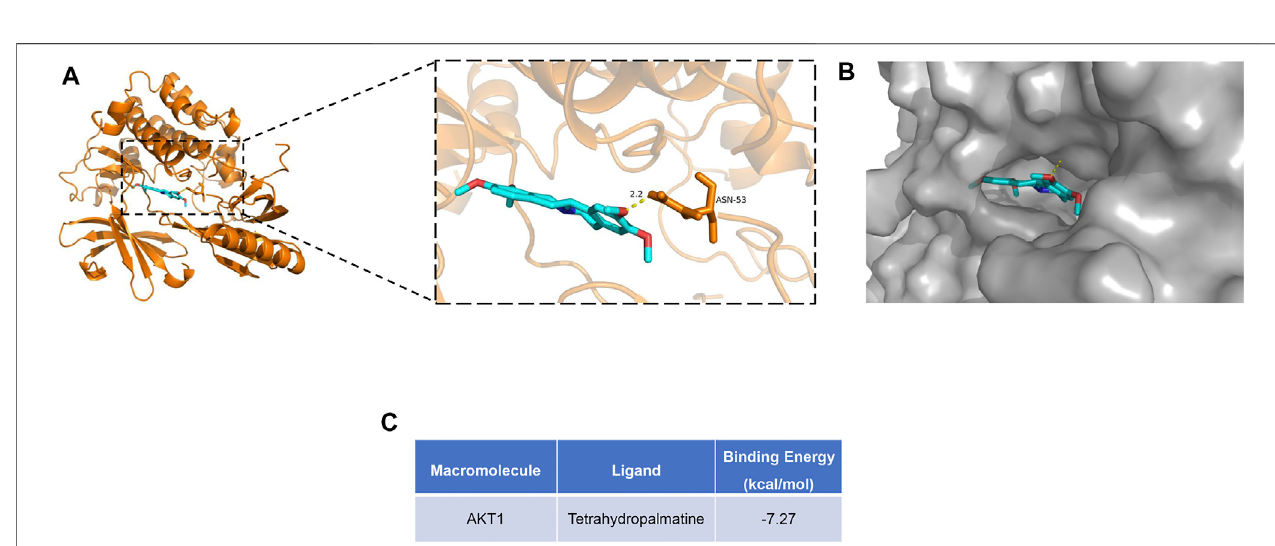
FIGURE6| MoleculardockingdiagramofAktwithTHP. (A) StructurediagramofAktdockedwithTHP.Yellowlinesrepresenthydrogenbond. (B) Surfacediagram of Akt docked with THP. (C) The binding energy for THP docked into the Akt crystal structure.